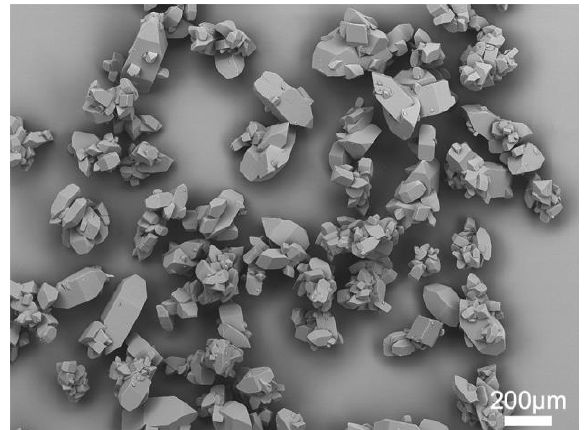
Figure 1. SEM image of commercial azithromycin.